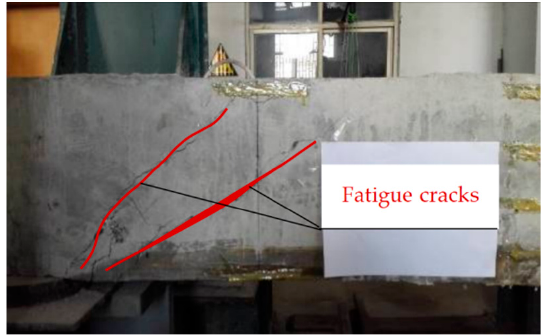
Figure 5. Fatigue load crack diagram of the test